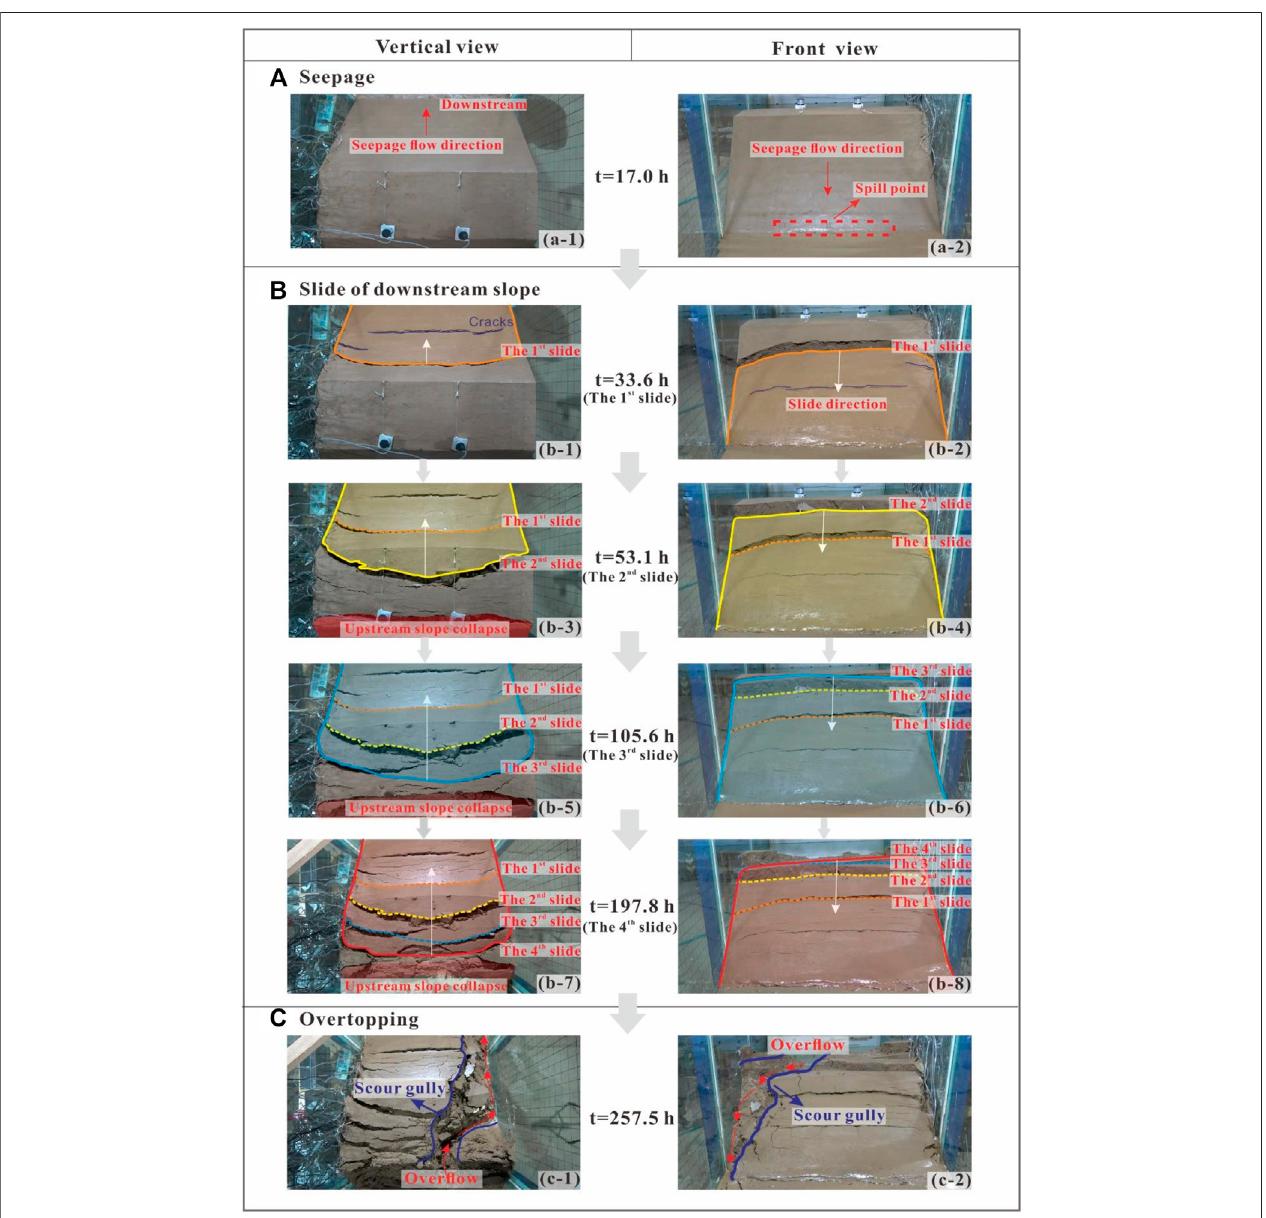
FIGURE 5 | Progressive failure process of model dam by vertical view and front view. (A) Seepage, (B) slide of downstream slope, and (C) overtopping.